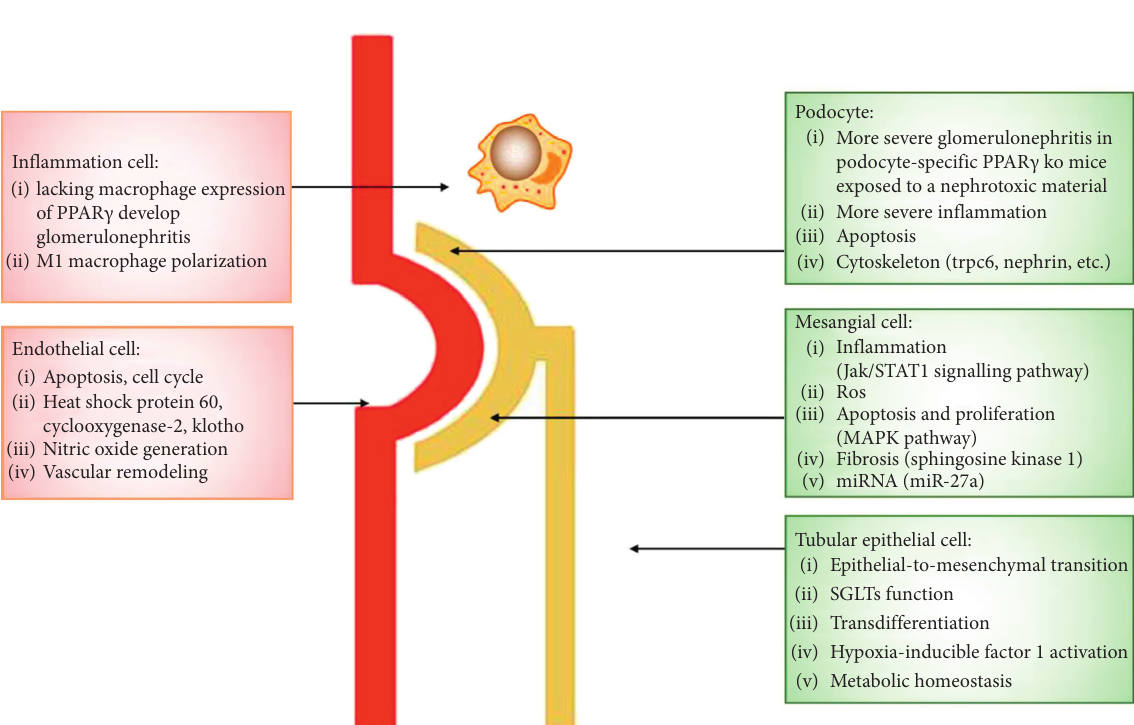
Figure 1: PPAR c function in kidney.